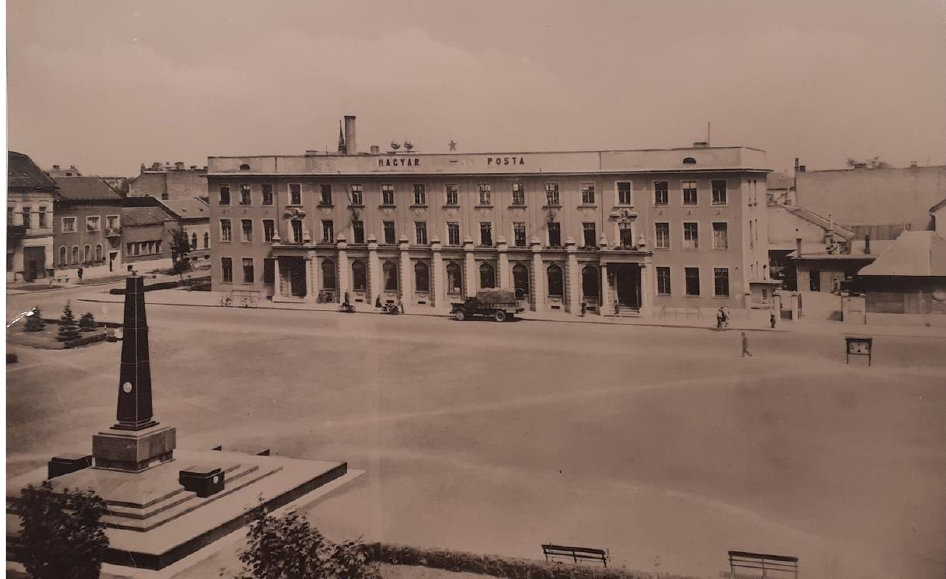
Figure 2. Hero’s square in 1962 with the postal palace (Architect: Gyula Wälder, 1937). The demol- ished house of Jen ő Stamberger (3 Horváth Lajos street, Architect: Victor Bohm, 1932) can be seen in the left corner. Source: Pál Száva personal archive.